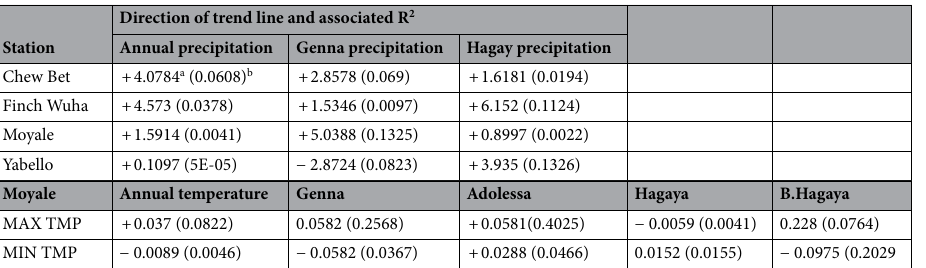
Table 3. Seasonal and annual precipitation/temperature slopes of the linear regression and R 2 values. Source (Author): Computed based on data from the NMA of Ethiopia. a Slope and b R 2 .